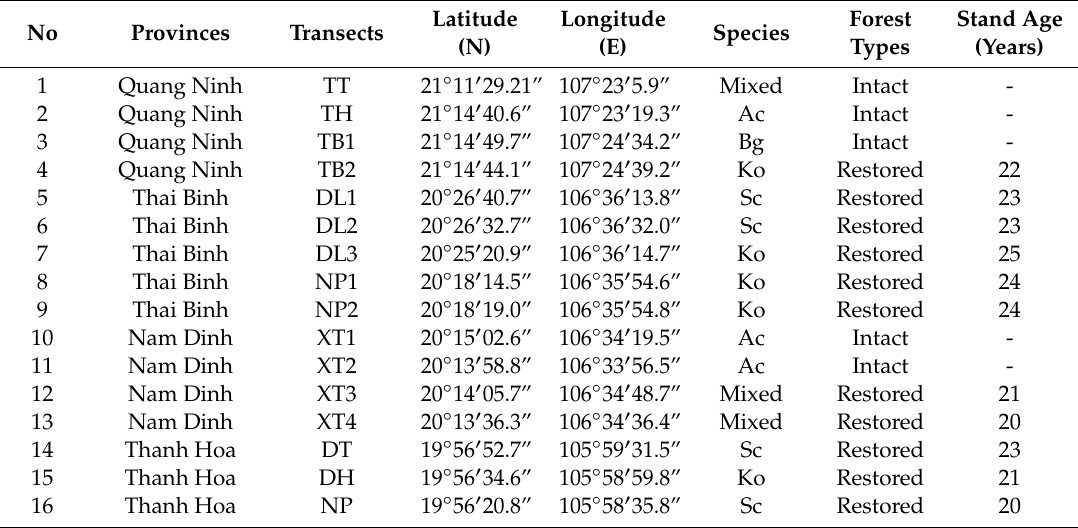
Table 1. Mangrove descriptions of study sites and